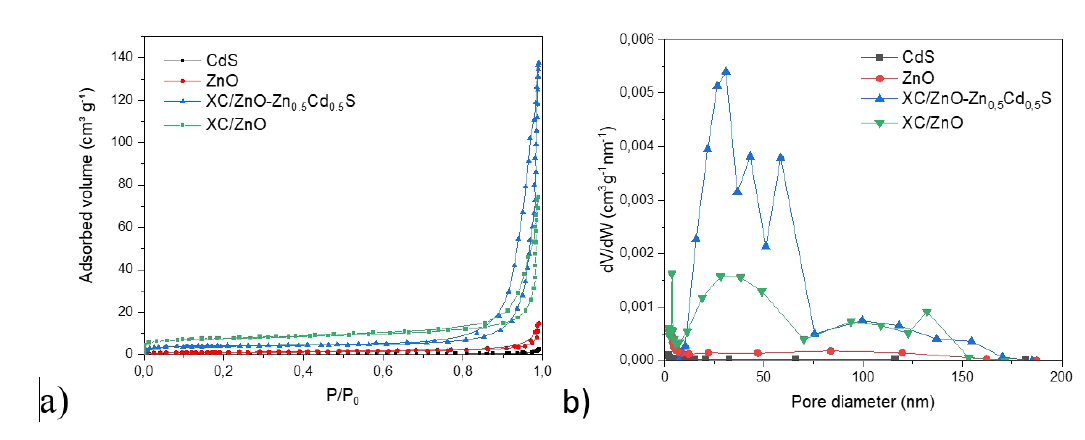
Cd S; b) Pore diameter distribution for the ZnO, CdS, and XC/ 0.5 0.5